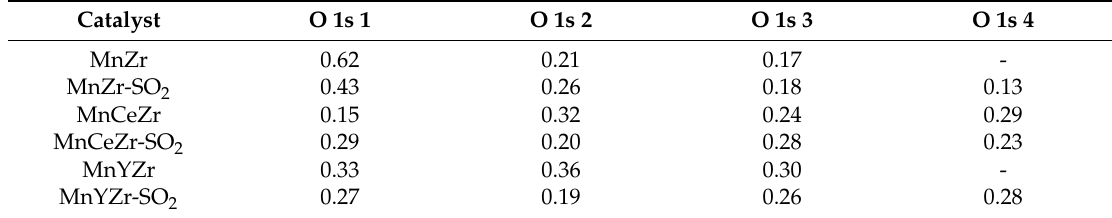
Table 2. Proportions of different O species obtained by the peak fitting of the O 1s curves.